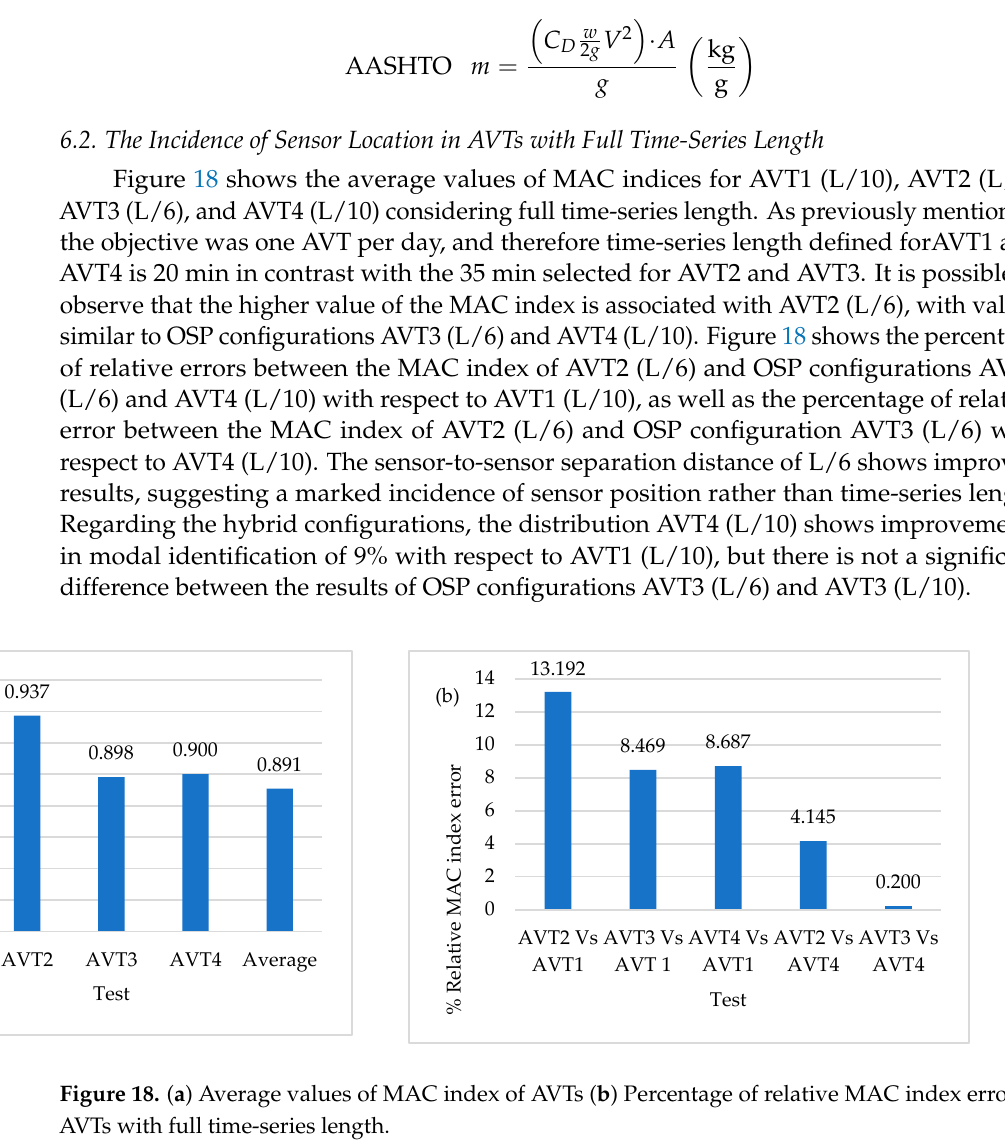
Figure 19. ( a ) Average values of MAC index ( b ) Percentage of relative MAC index error of AVTs with reduced time-series length.